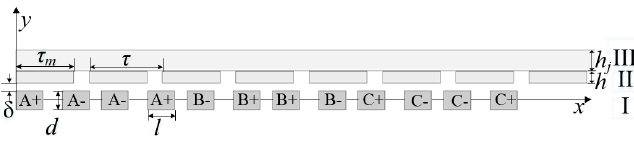
Figure 2. Layer analysis model of the PMSLM.